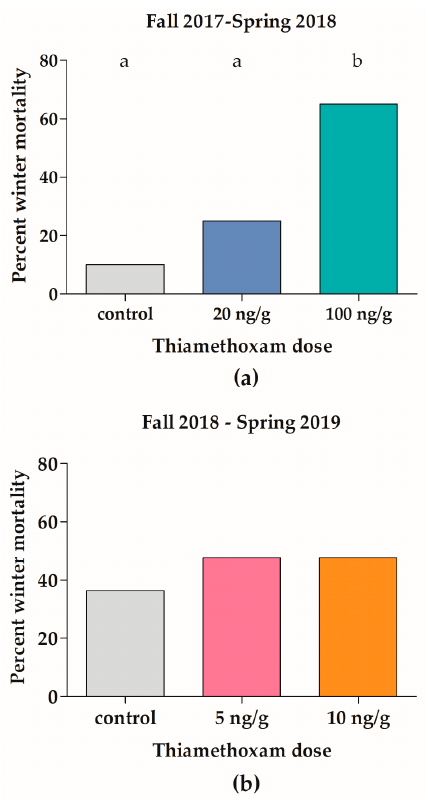
Figure 2. Chronic high-dose (100 ng/g) thiamethoxam significantly increases overwinter mortality of Apis mellifera colonies in the field. Honey bee colonies were chronically exposed to thiamethoxam over winter in field trial 1 (2017–2018) ( a ) or field trial 2 (2018–2019) ( b ), and survival of the colonies was evaluated the following spring. Bars indicate percent overwinter colony loss for twenty to twenty-two colonies per group. Different letters indicate significant differences by a z-test, p < 0.05.